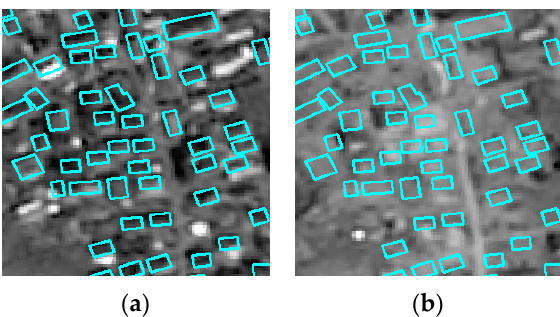
Figure 16. Examples of the estimation of a TP by an indicator >0.3 drawn in blue outline on a: ( a ) 20 March 2016 SPOT image; and ( b ) 25 March 2018 SPOT image. Remote Sens. 2019 , 11 , 2190